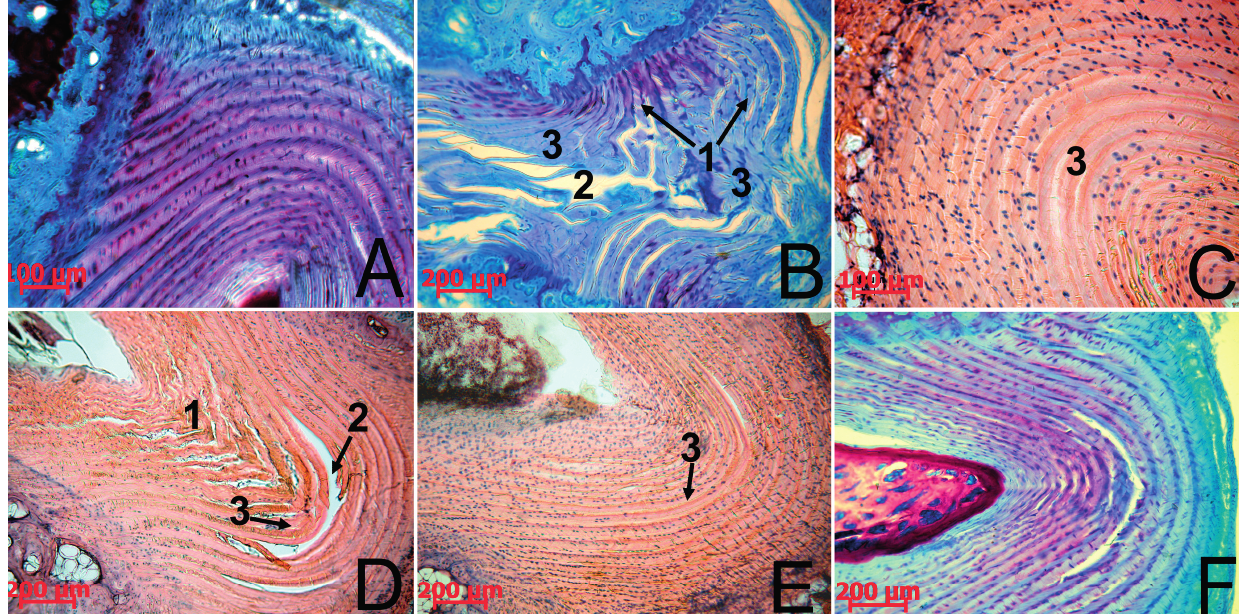
Figure 2. The IVD Co6–Co7 in rats. Collagen fiber fragmentation (1), central tears and clefts (2), and areas with low fibrochondrocyte density or complete absence of cells (3) were observed in the AF of animals without treatment ( B ) even on the 90th day. In this group, metachromatic staining similar to the intact animals ( A ) was absent. The decrease in collagen fiber fragmentation and the significant reduction in the area occupied by tears, clefts, and acellular sites were observed in the AF of animals after native MSC therapy on the 30th day ( C ) and cryopreserved MSC therapy on the 30th ( D ) and 60th ( E ) days. On the 90th day, after cryopreserved MSC administration ( F ), almost complete recovery of the AF histological structure and its metachromatic staining was